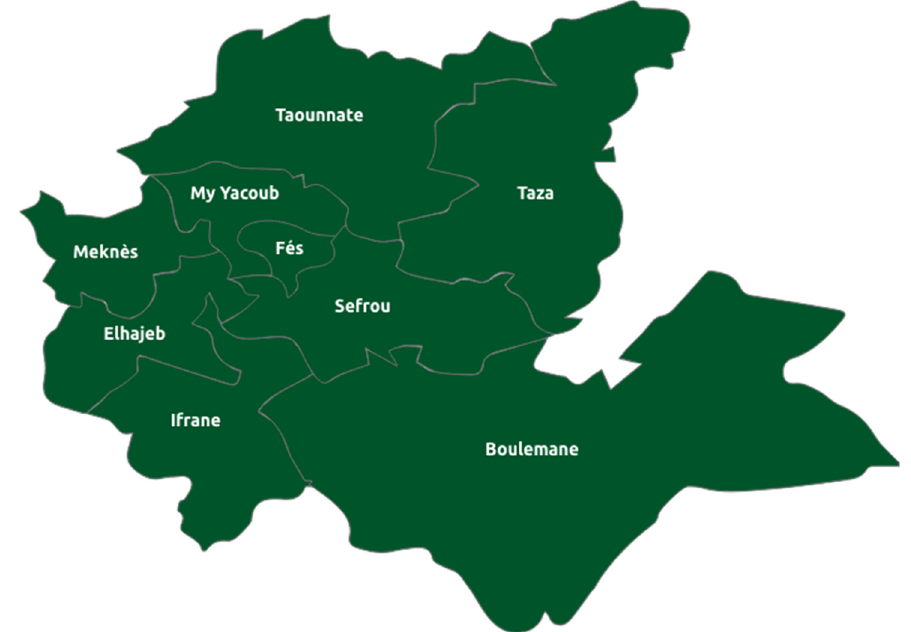
Figure 2. Map of the Region Fez-Meknes [32].